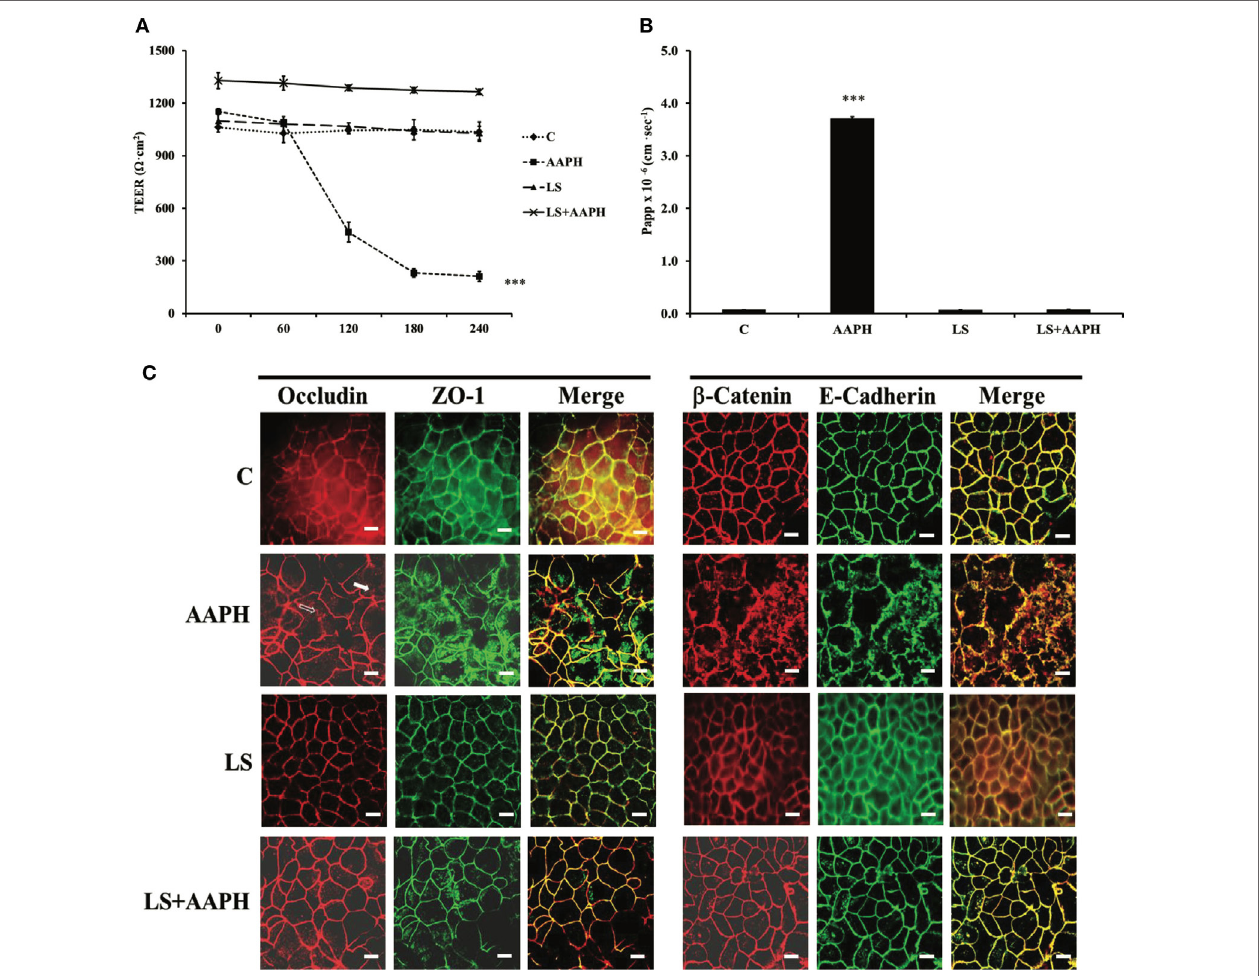
FigUre 1 | Effect on barrier integrity: protective effect of Lactobacillus casei Shirota (LS) in inhibiting the increased membrane permeability caused by AAPH in human colon carcinoma cell line cells. Cells differentiated on transwell filters were untreated (C), treated with AAPH (AAPH), treated with LS or pretreated with LS for 1.5 h, and then treated with AAPH (LS + AAPH) for 2.5h. Transepithelial electrical resistance [TEER, (a) ] was measured every 60 min, from 0 to 240 min and reported as Ohm × cm 2 . After treatments, phenol red was added in the apical compartment, for 1 h, and then determined spectrophotometrically in the basolateral compartment. The results are expressed as apparent permeability [Papp, (B) ]. Values represent mean ± SD of at least three independent experiments, carried out in triplicate. *** Statistically different from control cells ( P < 0.001). Cells were labeled with specific primary antibodies for tight (ZO-1 and occludin) and adherent ( β -catenin and E-cadherin) junction proteins (c) , followed by tetramethylrhodamine isothiocyanate (TRITC)- and fluorescein isothiocyanate (FITC)-conjugated secondary antibodies for occludin and ZO-1 and for β -catenin and E-cadherin, respectively. As shown, AAPH treatment determined the loss of the membranous continuous staining of ZO-1, occludin, β -catenin, and E-cadherin. Dissociation of occludin from membrane is indicated by arrows. Regular localization of tight and adherent junction proteins is visible in cells treated with LS alone or pretreated with LS before AAPH treatment. Each figure is representative of three independent immunofluorescence assays (63 × magnification). Bars represent 10